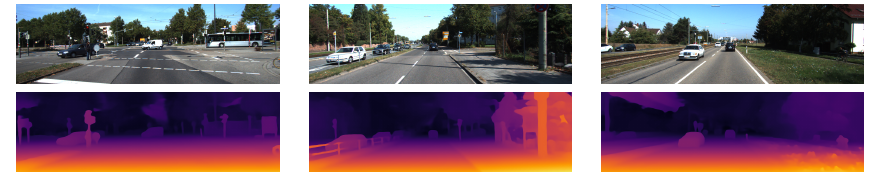
Figure 5. The qualitative results from [28] show the left RGB images from 3 scenes in the KITTI-2015 stereo dataset in the top row and the corresponding disparity map predictions in the bottom row are shown using colour to represent the disparity